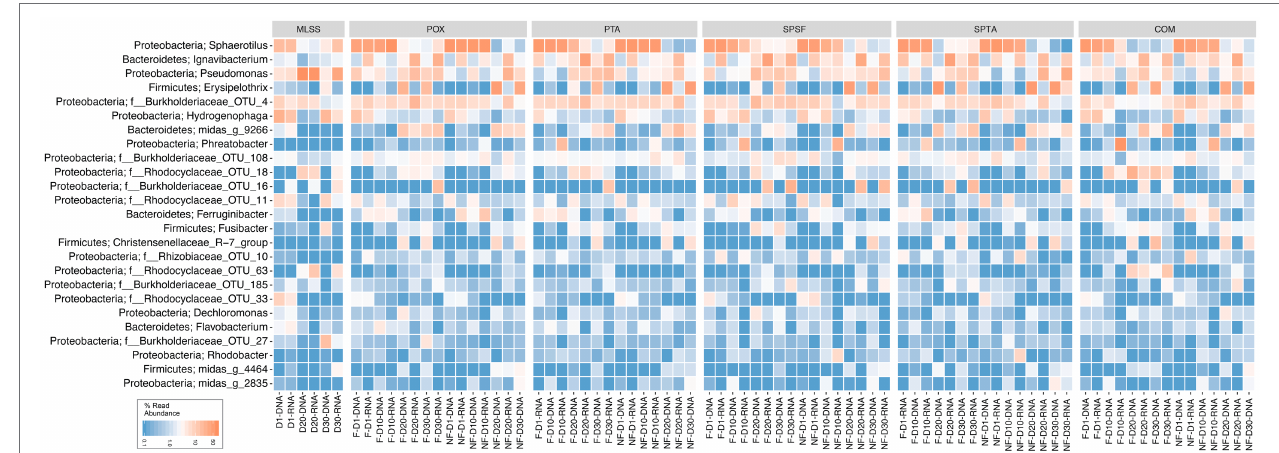
FIGURE 1 | Heatmap distribution of the top 25 taxa classified down to genus-level or the lowest classifiable taxonomic level (f, o, c, and p represent family, order, class, and phylum, respectively) derived from membrane biofilms and mixed liquor samples. The color intensity in each cell reflects relative reads abundance of taxa in the corresponding sample. POX (polyoxadiazole), PTA (polytriazole), SPTA (sulfonated polytriazole), SPSU (sulfonated polysulfone), and COM (commercial PVDF membrane) membranes were operated under 10 LMH flux (F) and without permeate flux (NF). Mixed liquor suspended solids (MLSS) corresponds to the mixed liquor suspended solids sample. D1, D10, D20, and D30 refer to sampling days 1, 10, 20, and 30, respectively. DNA and RNA represent 16S rRNA gene amplicon sequencing dataset from DNA and cDNA samples, respectively. The heatmap generated was based on a rarefied dataset sub-sampled to 4,386 sequences per sample. The dataset used in this analysis includes both flux and no flux